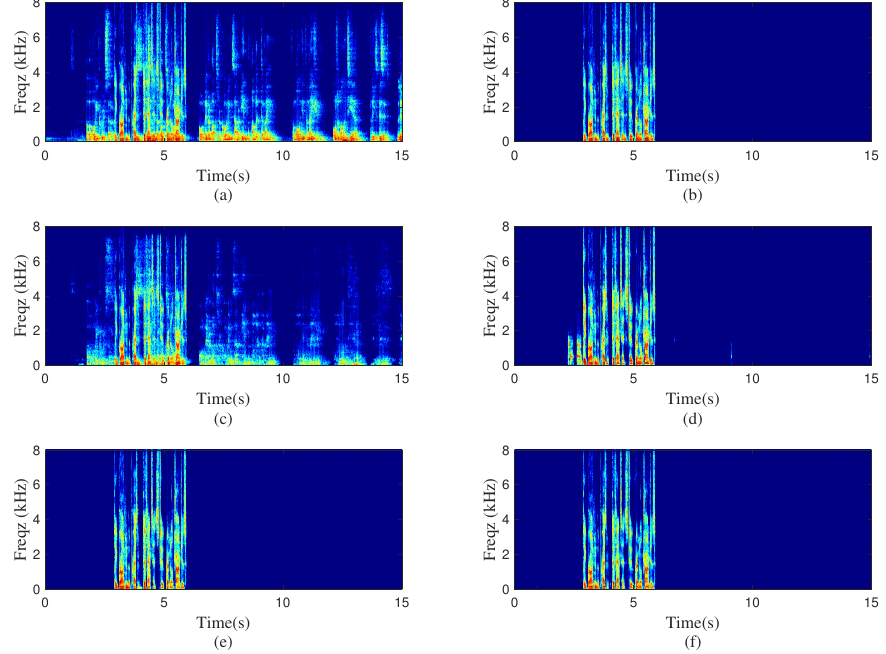
Figure 6. Spectrograms processed by different methods with nonstandard loudspeakers lay- out. ( a ) Microphone signal, PESQ = 2.45, ( b ) clean near-end speech, ( c ) PBFDLMS algo- rithm, ERLE = 14.07 dB, PESQ = 2.59, ( d ) D-format model-based algorithm, ERLE = 17.71 dB, PESQ = 2.76, ( e ) Singlechn model-based algorithm, ERLE = 52.56 dB, PESQ = 2.85, ( f ) B-format model-based algorithm, ERLE = 54.73 dB, PESQ =